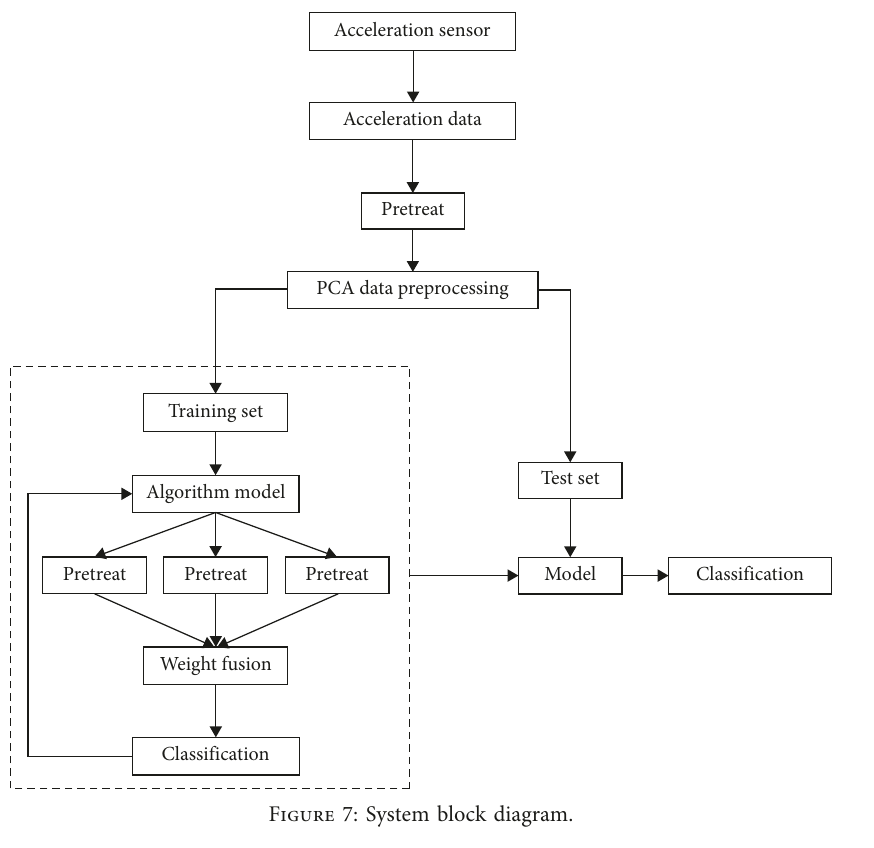
Figure 7: System block